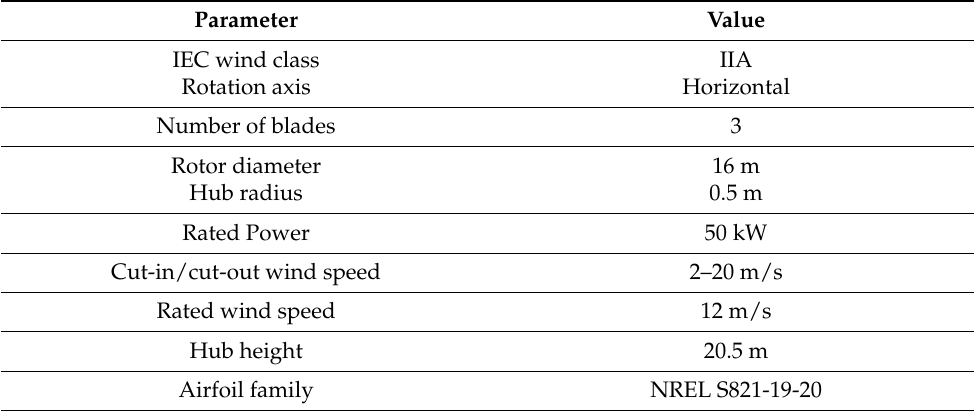
Table 1. Turbine specifications. IEC: International Electrotechnical Commission.